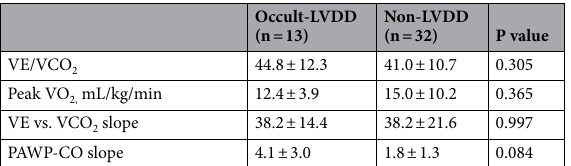
Table 2. Haemodynamic Parameters at rest (after leg raise), anaerobic threshold, and peak exercise. Values are reported as mean ± standard deviation (SD). BP, blood pressure; CO, cardiac output; HR, heart rate; LVDD, left ventricular diastolic dysfunction; PAC, pulmonary artery compliance, PAP, pulmonary artery pressure; PAWP, pulmonary artery wedge pressure; PVR, pulmonary vascular resistance; RC time, the time constant of the pulmonary circulation, SaO 2 , O 2 saturation in arterial blood; SvO 2 , O 2 saturation in the pulmonary artery; VO